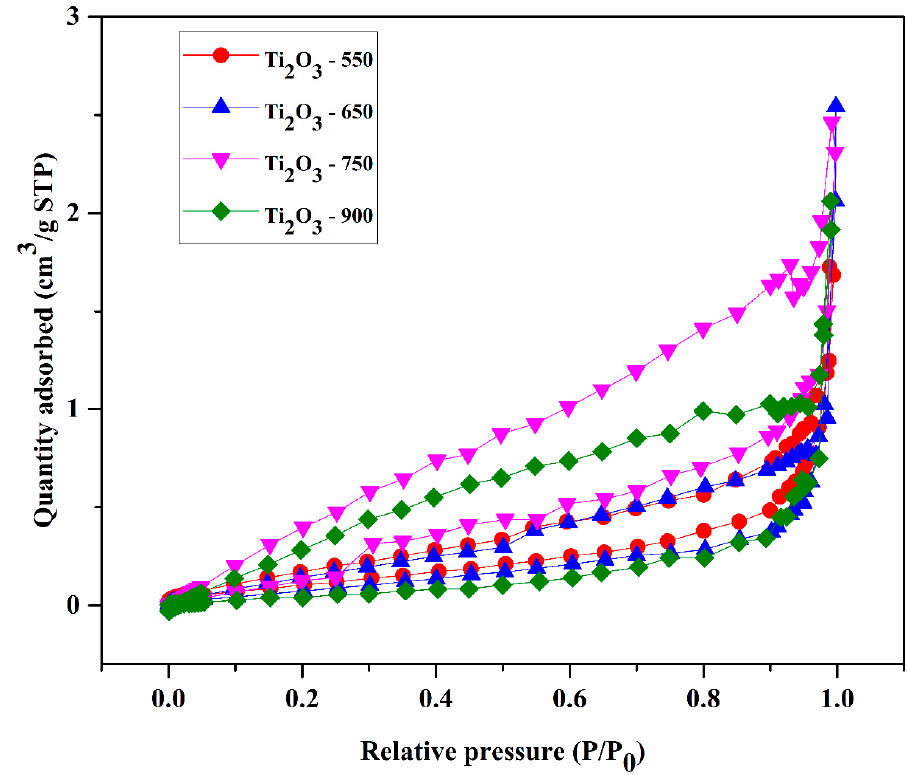
Figure 6. N 2 adsorption/desorption of treated Ti 2 O 3 catalysts.